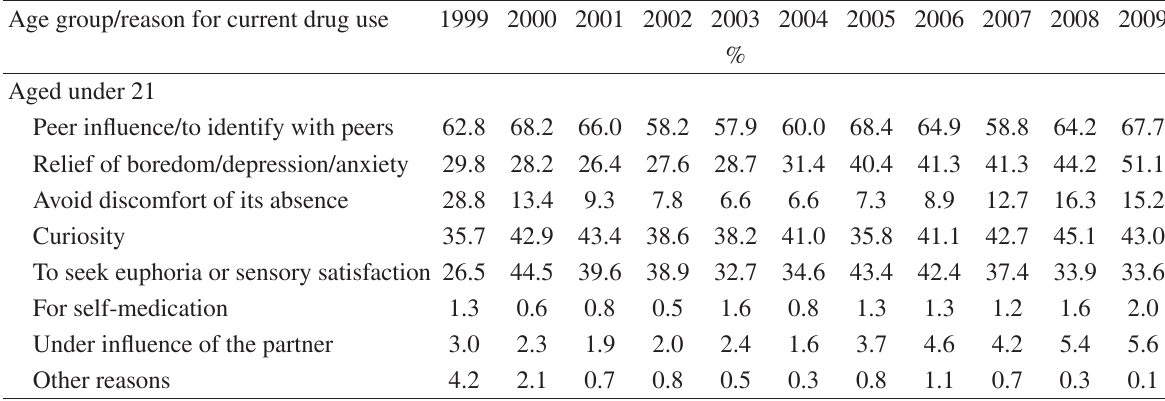
TABLE 5: Reported drug abusers for 1999–2009 by age group by reason for current drug use based on the Central Registry on Drug